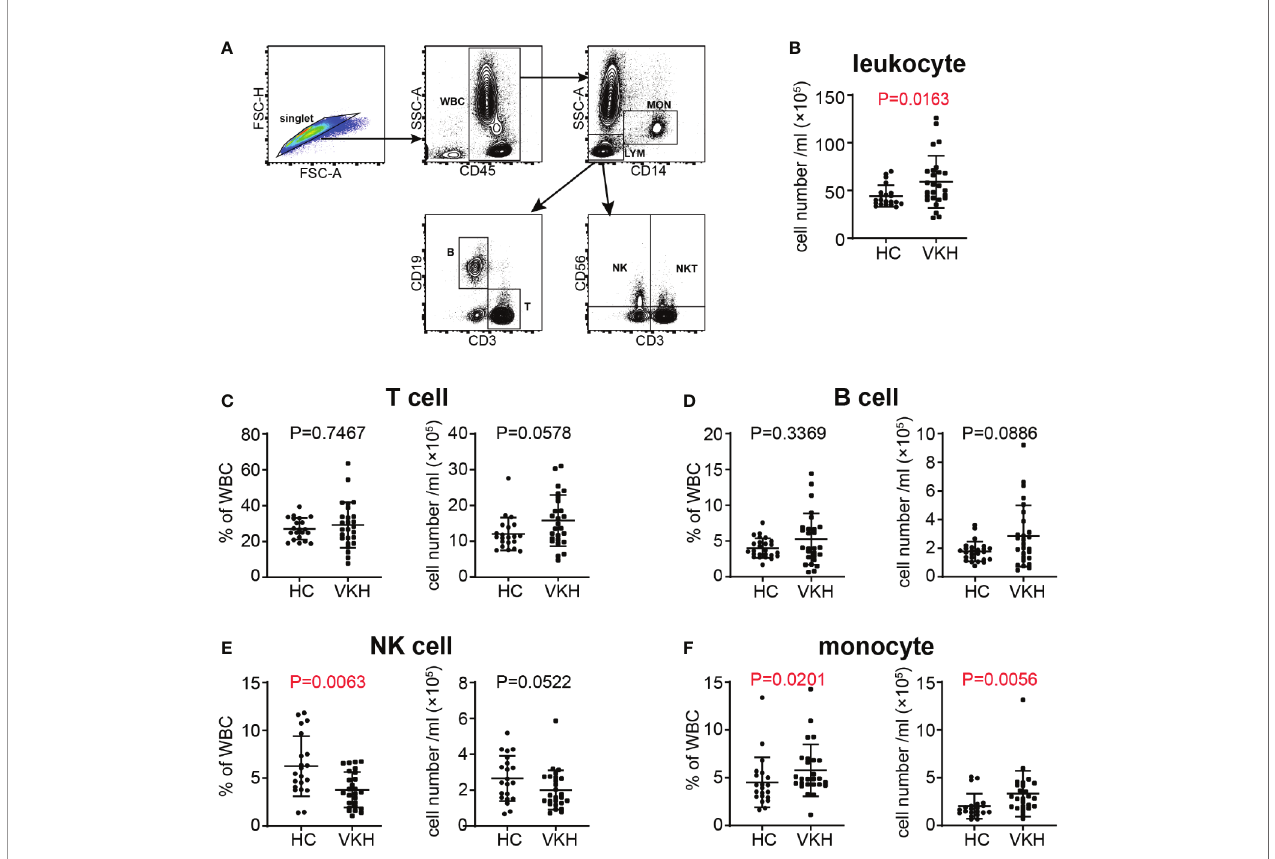
FIGURE 1 | Changes of white blood cells in peripheral blood of VKH patients compared with healthy controls. (A) Gating strategy used for the characterization of leukocyte subpopulations. (B) The absolute number of leukocytes. (C) The absolute number and proportion of T cells. (D) the absolute number and proportion of B cells. (E) The absolute number and proportion of NK cells. (F) the absolute number and proportion of monocytes. Statistical analysis was performed using Mann – Whitney test. WBC, white blood cells; LYM, lymphocytes; MON, monocytes; T, T lymphocytes; B, B lymphocytes; NK, natural killer cells; NKT, natural killer T